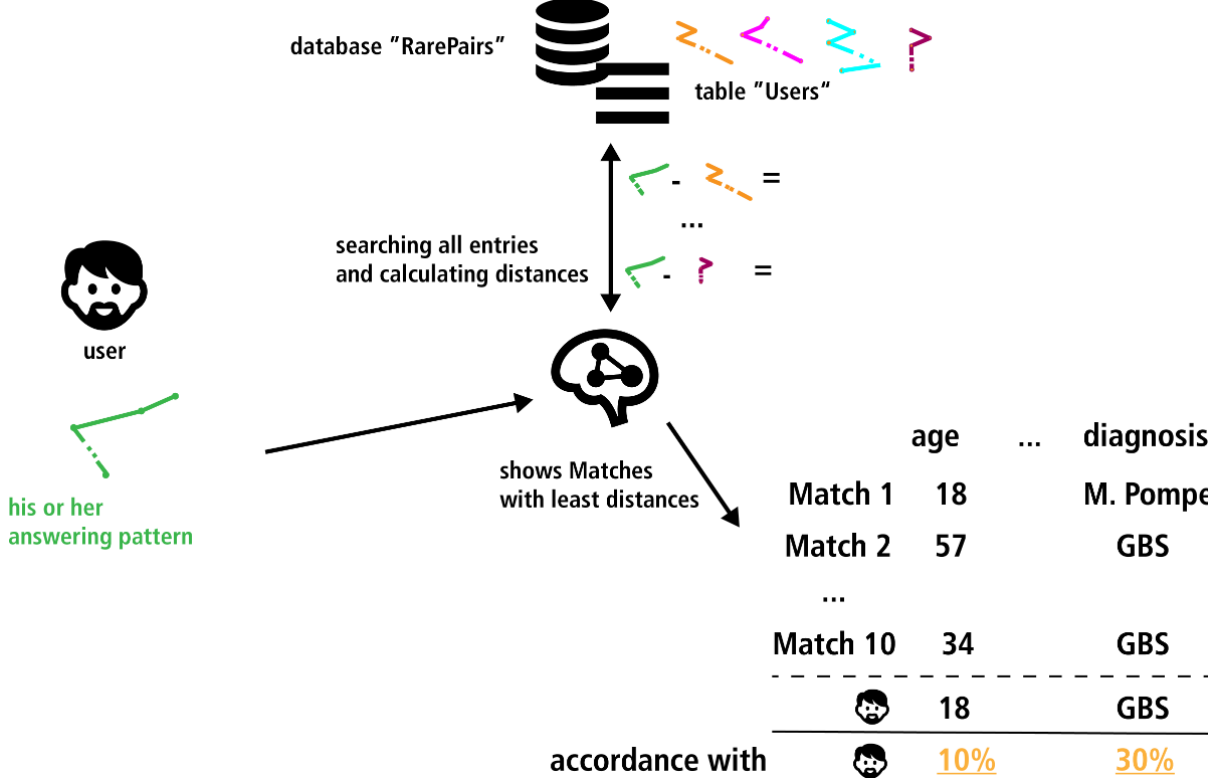
Figure 5. Illustration of the first part of identifying a matching method. Screening the data set for 10 "best" matches for one user (using the leave-one-out-method). This scheme only illustrates the basic principle of the simulation. The exact results are shown in Table 1. GBS: Guillain-Barré syndrome; M. Pompe: Morbus Pompe.